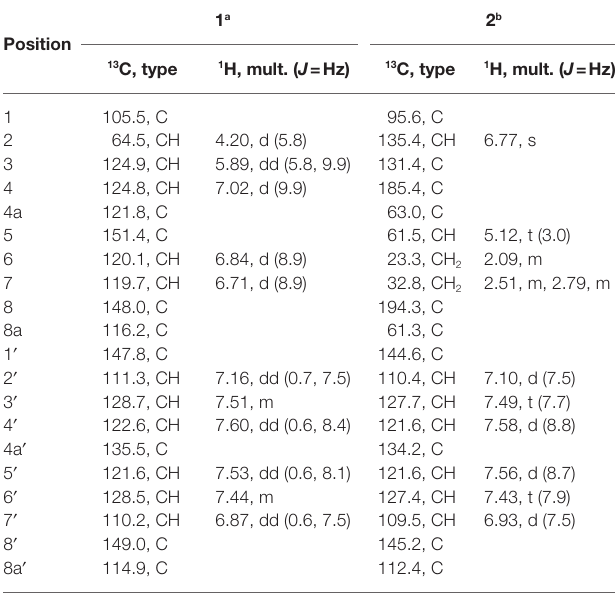
TABLE 2 | NMR spectral data of palmarumycin CP 30 ( 1 ) and palmarumycin C